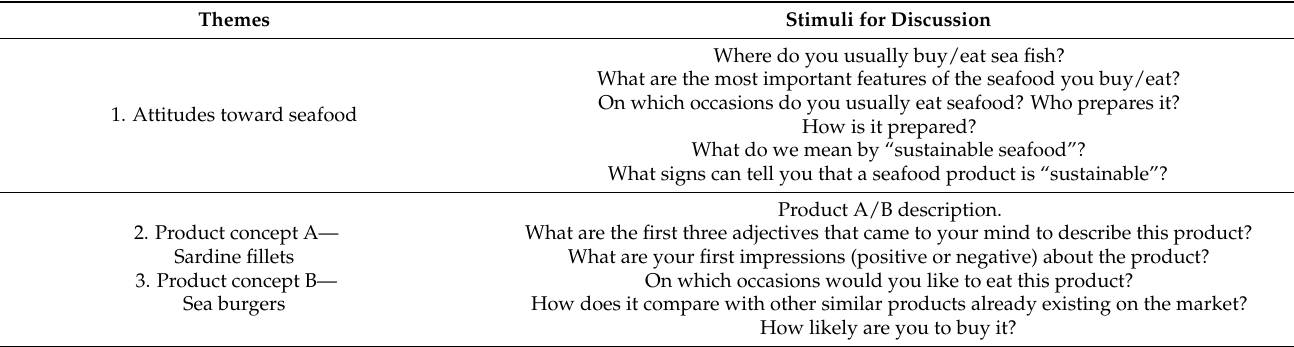
Table 2. Discussion themes and related